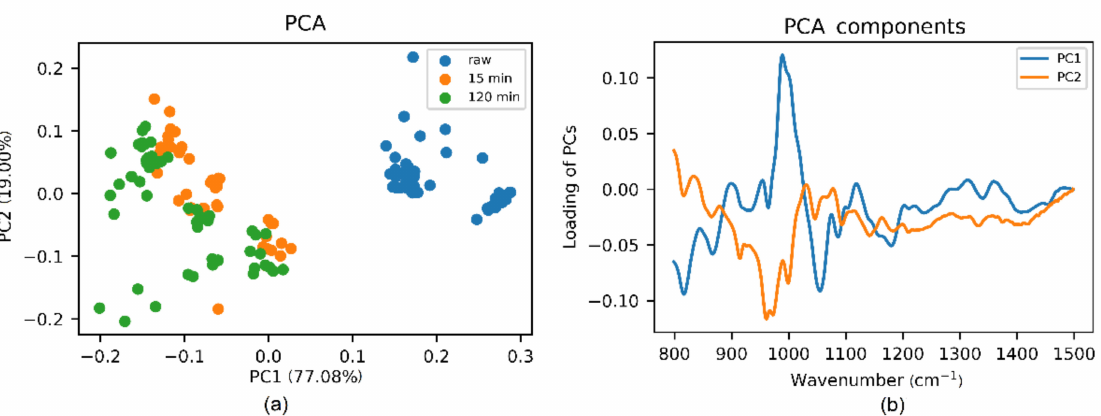
Figure 3. ( a ) Principal component score plot and ( b ) loading plot of PCs of raw and thermally treated eucalyptus honey samples—15 and 120 min at 70 ◦ C—based on PCA applied to the spectral range of 800–1500 cm − 1 from FTIR